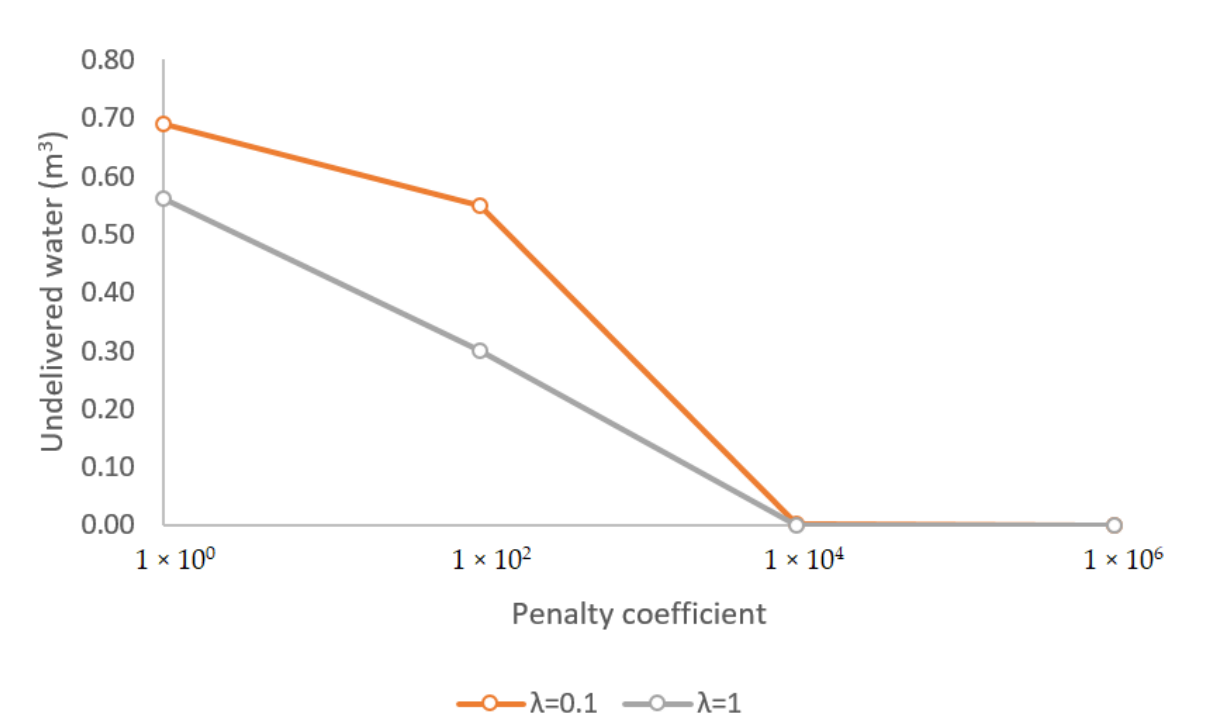
Figure 6. Relation between the total undelivered demand (m 3 during peak hour) and the considered variance-factor ( λ ) and penalty coefficient ( Cpen ) in the optimization model (considering historic demand scenarios). The different colors indicate the considered variance-factor in the optimization model. The total undelivered demand under the historic scenarios is lower for the higher variance-factor ( λ = 1).